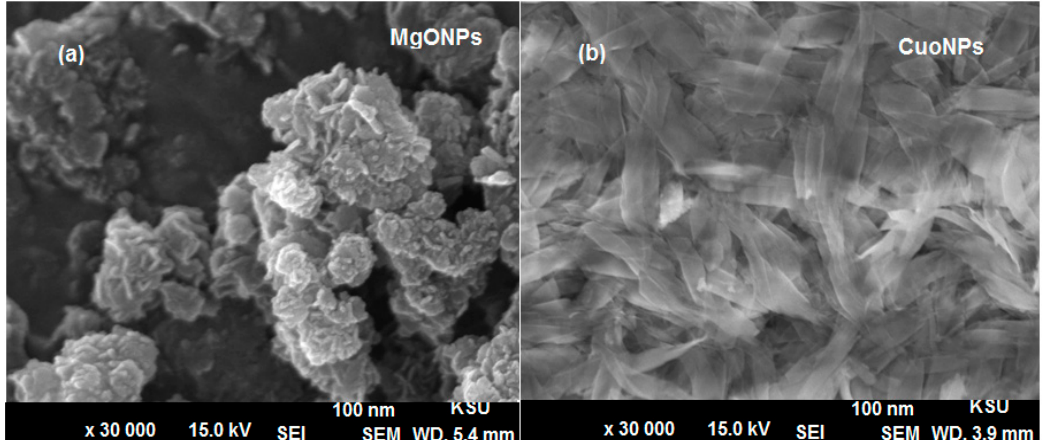
Figure 6. Scanning electron microscope (SEM) images of ( a ) MgONPs and ( b ) CuONPs at acceleration voltage 15.0 kV and magnification × 30,000.